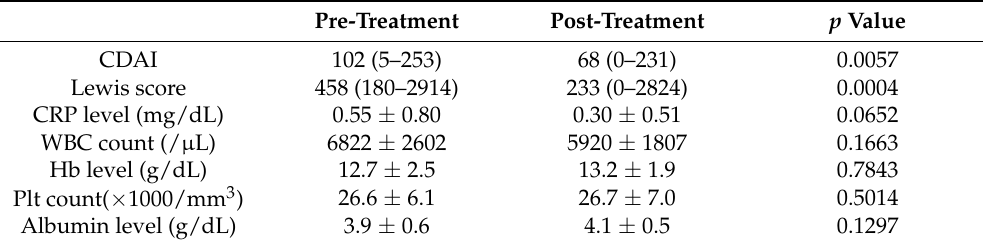
Table 3. Biomarker levels at baselines and 6 months